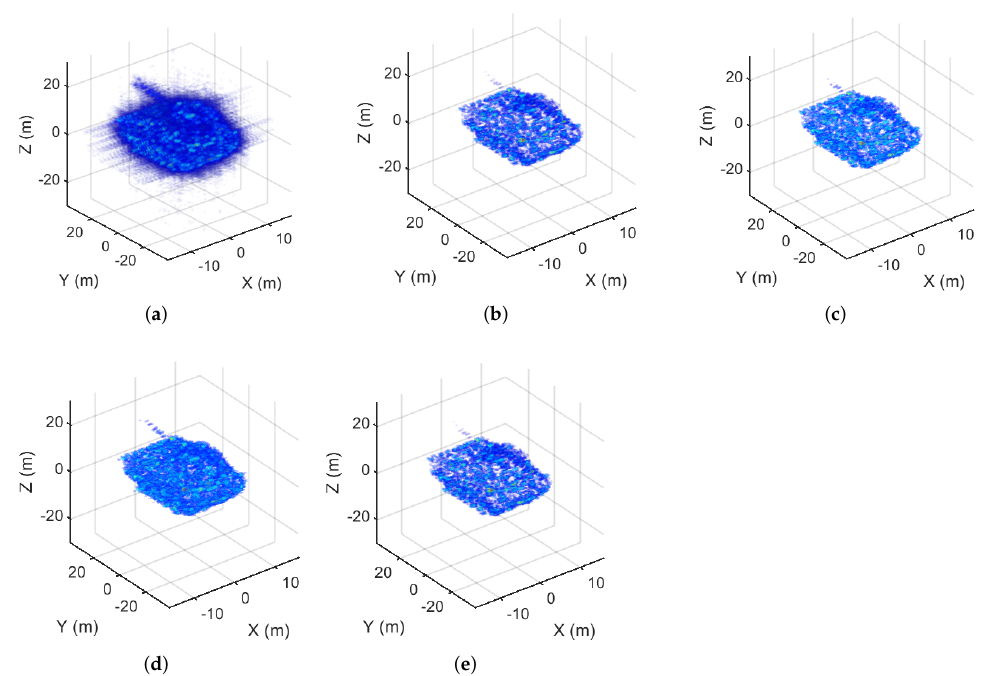
Figure 2. The imaging results of the combat vehicle corresponding to the 100% sampling rate. ( a ) The MF result. ( b ) The MM- L 1 result. ( c ) The MM- L 1/2 result. ( d ) The MM- L 0 result. ( e ) The GMM- L 0.8 result.